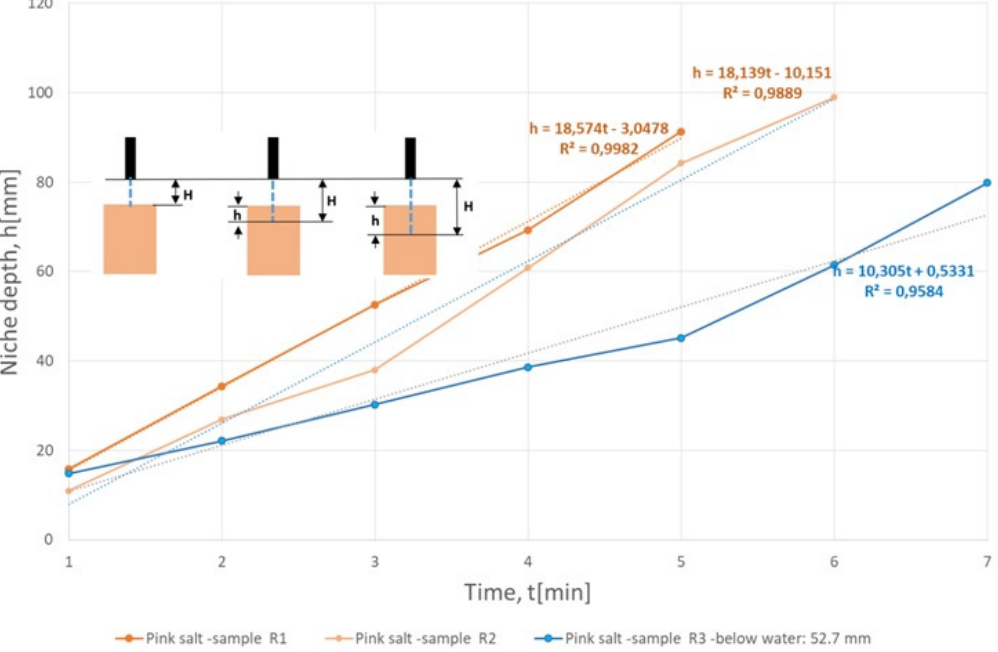
Figure 11. Average depth of cut niche as a function of water cutting time-pink salt. Nozzle’s displacement velocity v = 100 (mm/min). Water jet pressure p = 500 bar.